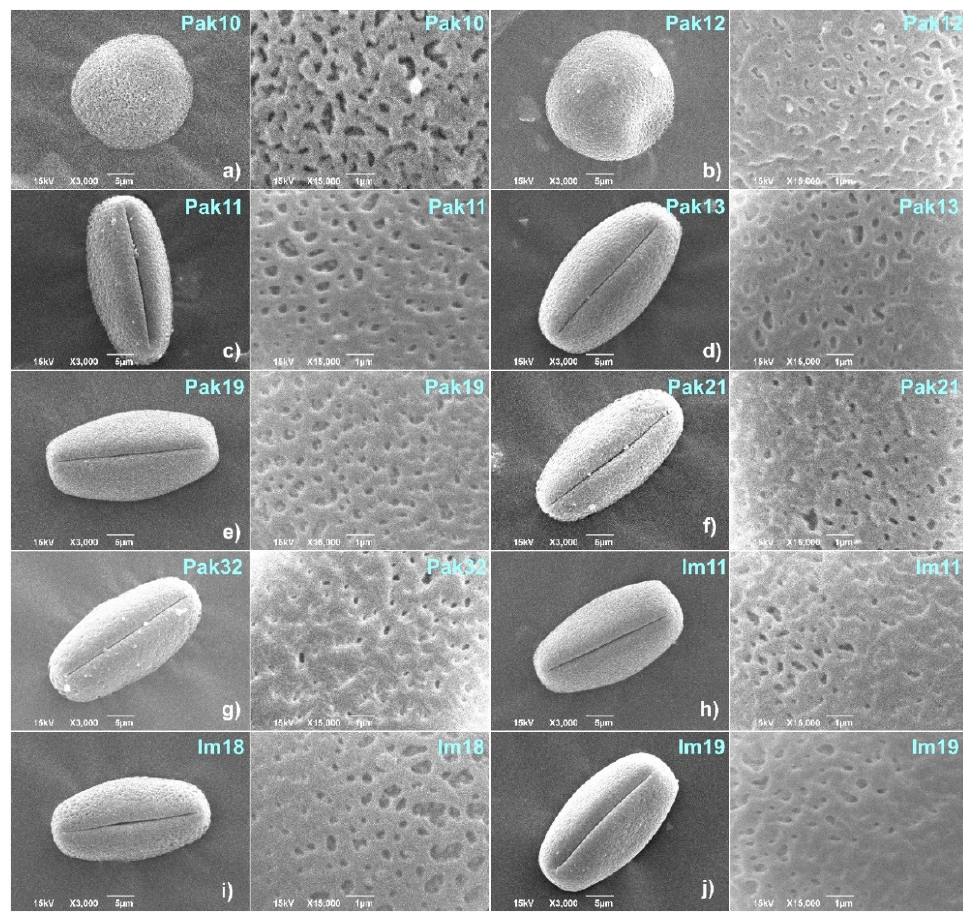
Figure 2. Equatorial view and detailed exine pollen surface in ten V. sylvestris genotypes (two female ( a , b ) and eight male ( c – j ). Each individual is represented by two images in line showing whole pollen grain (scale bar: 5 µm) and exine pattern (scale bar: 1 µm), respectively.